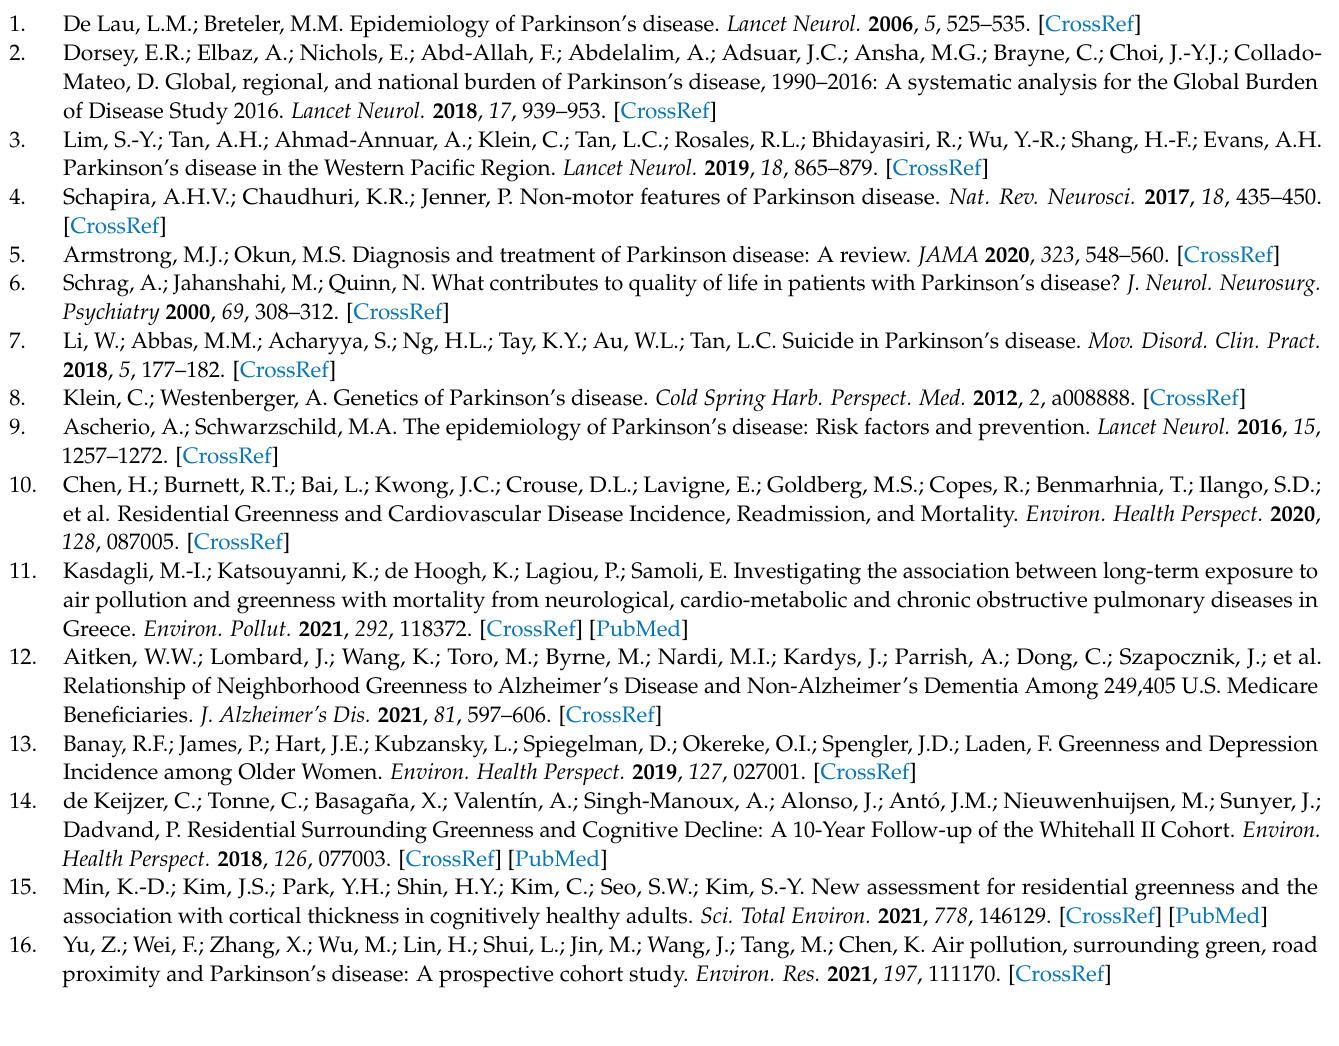
Table S1. Hazard ratios of long-term exposure to normalized difference vegetation index and on Parkinson’s disease in time-dependent Cox proportional hazards model and Cox proportional hazards model using various exposure windows; Table S2. Hazard ratios of long-term exposure to normalized difference vegetation index and on Parkinson’s disease in conventional Cox proportional hazards model using various exposure windows; Table S3. The association between 0.1 increase of normalized difference vegetation index and incidence of Parkinson’s disease among non-movers; Table S4. Hazard ratios of long-term exposure to normalized difference vegetation index and on Parkinson’s disease according to adjustment of different air